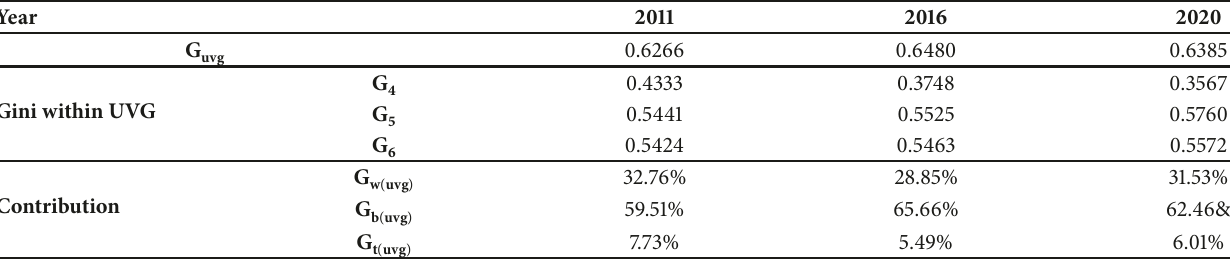
Table 7: Decomposition of the Gini coefficient of UVG between subgroups.